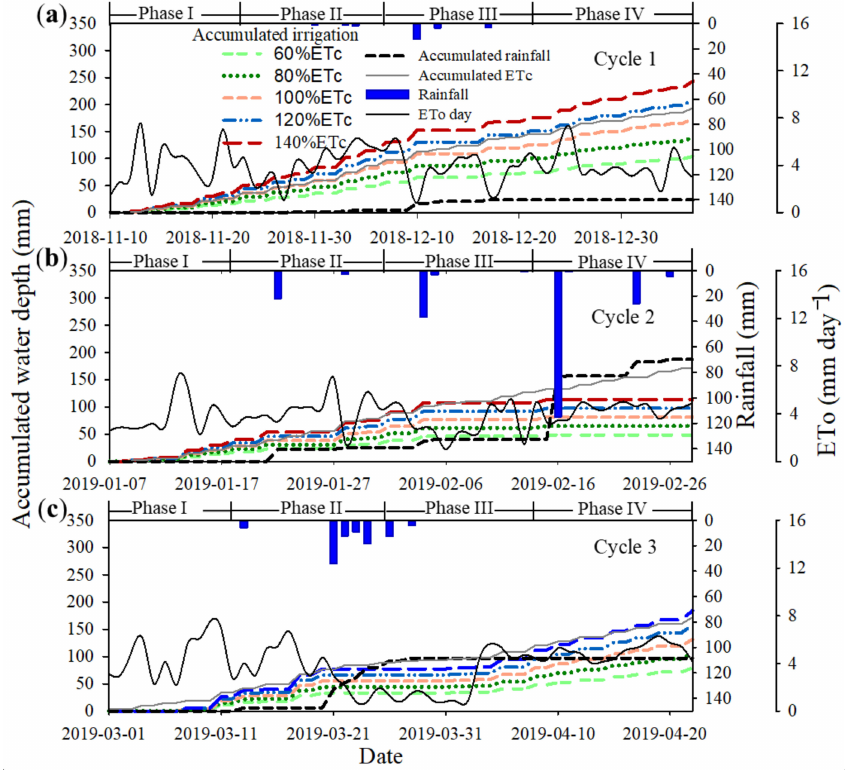
Figure 3. Temporal variation of precipitation, accumulated crop evapotranspiration (ETc) for 60%, 80%, 100%, 120%, and 140% of ETc depths, and daily reference evapotranspiration (ETo) for the forage sorghum in cycle 1 ( a ), cycle 2 ( b ) and cycle 3 ( c